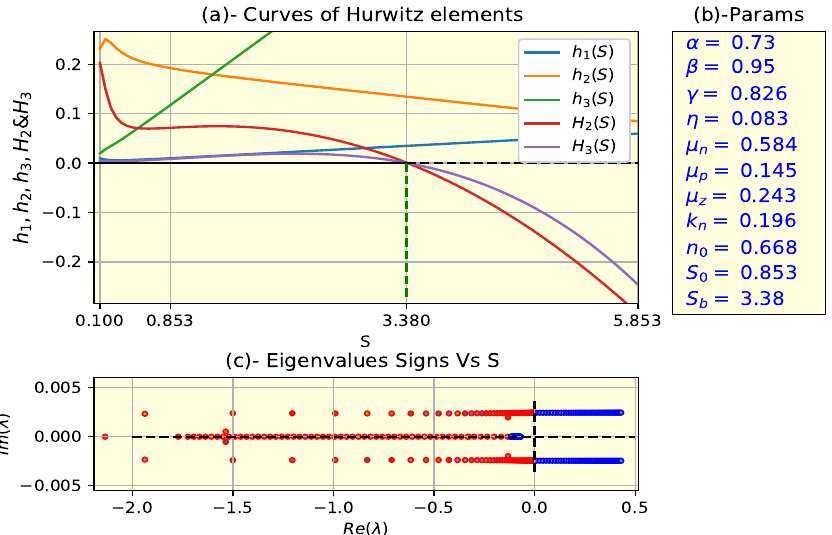
dH 2 , (b) -System’s b according to functions H 2 , dS